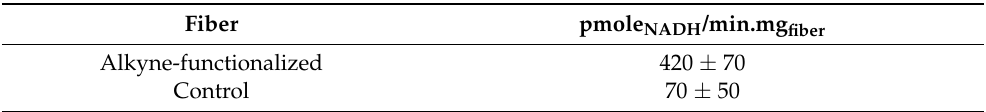
Table 5. Comparison of the enzymatic activity of alkyne-functionalized fibers and control (non- functionalized) fibers incubated with